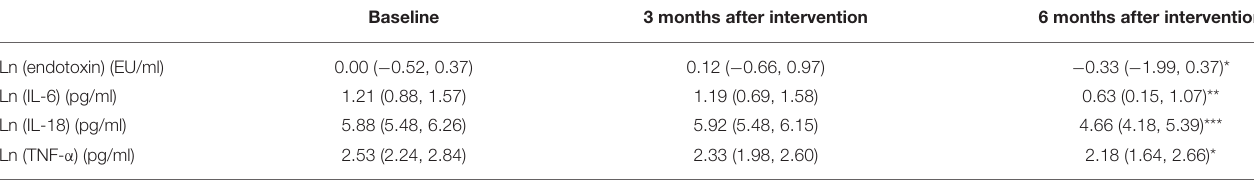
TABLE 3 | Effects of probiotics on the serum levels of endotoxin and proinflammatory cytokines. Baseline 3 months after intervention